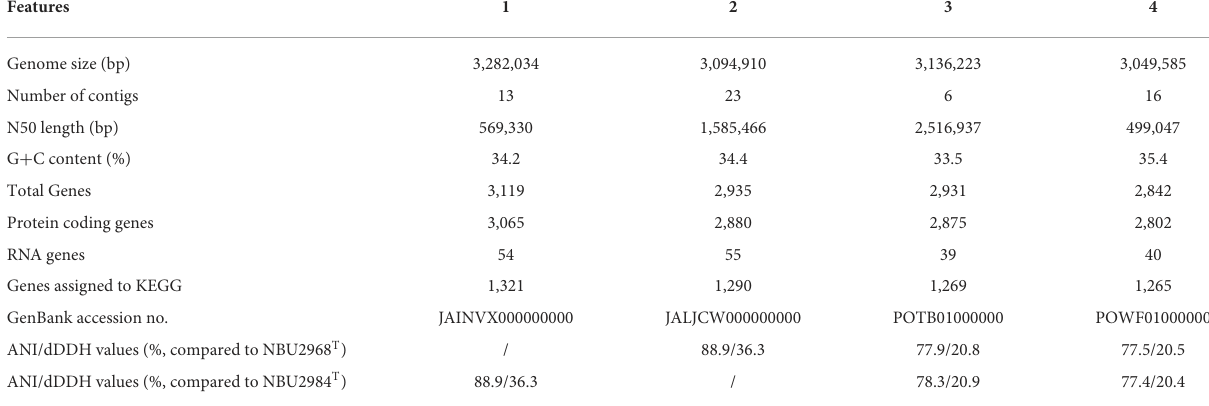
TABLE 3 The comparison of genomic features among strains NBU2968 T , NBU2984 T , and two species in the genus Hanstruepera